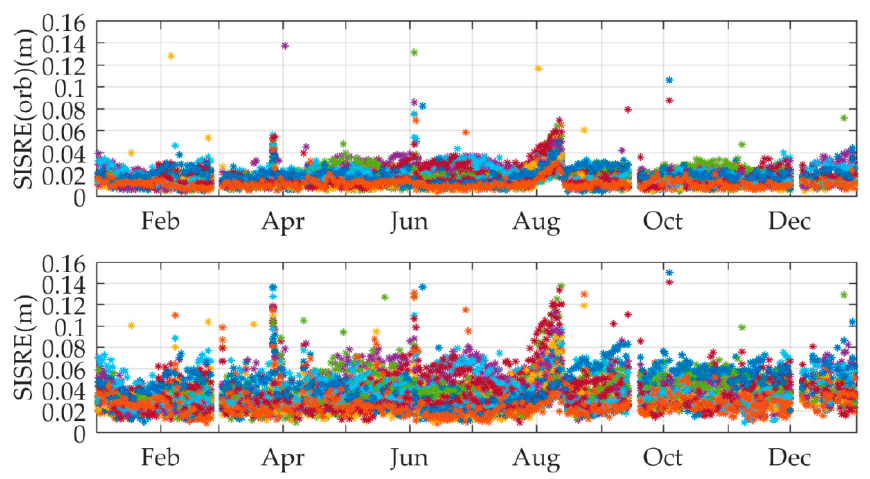
Figure 8. Daily RMS of orbit-error-only SISRE and SISRE of MADOCA real-time products for all available GPS satellites relative to IGS final products from 1 January 2018 to 31 December 2018.